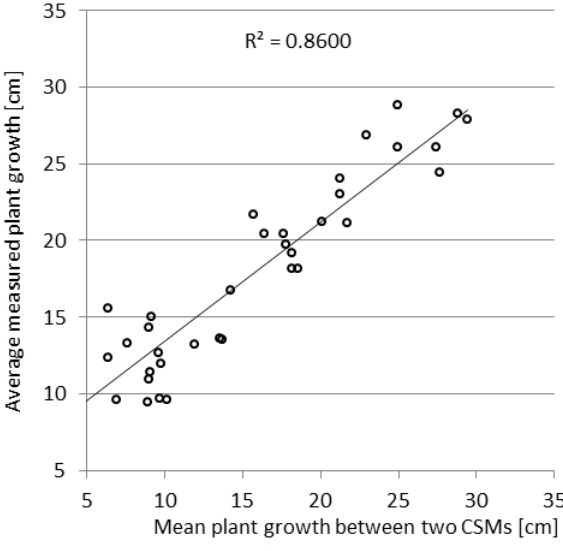
Figure 7. Regression of mean plant growth increase between two consecutive CSMs and average measured plant growth increase